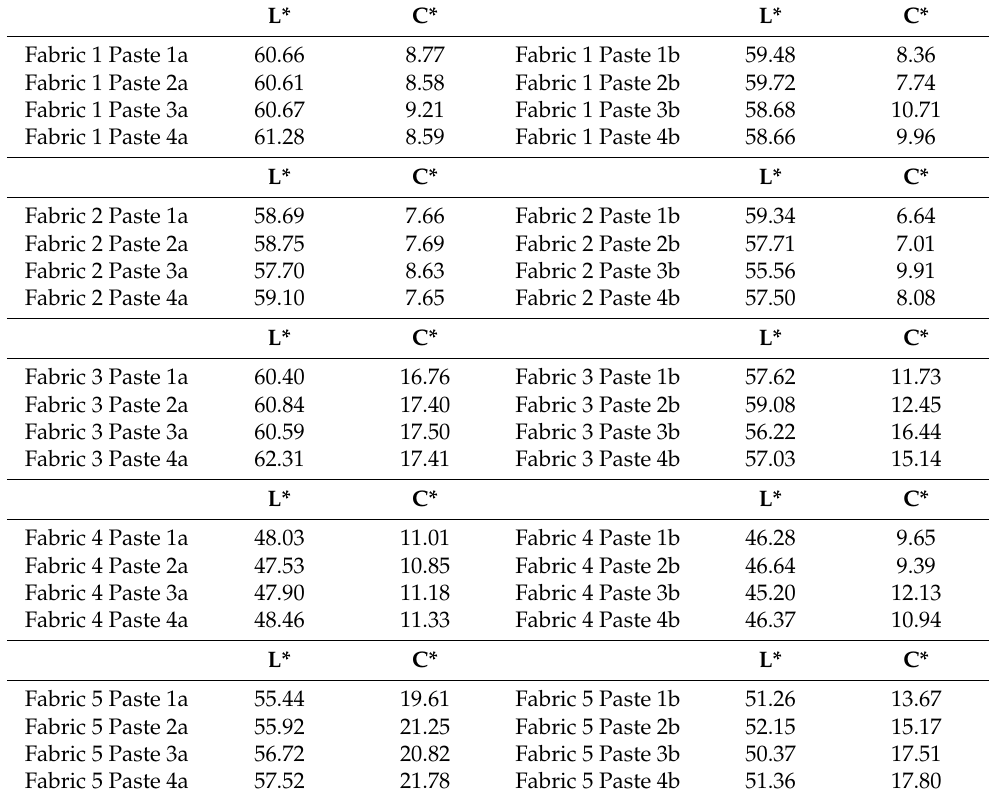
Table 8. Lightness (L*) and chroma (C*) relationship for printed samples after 5 washing